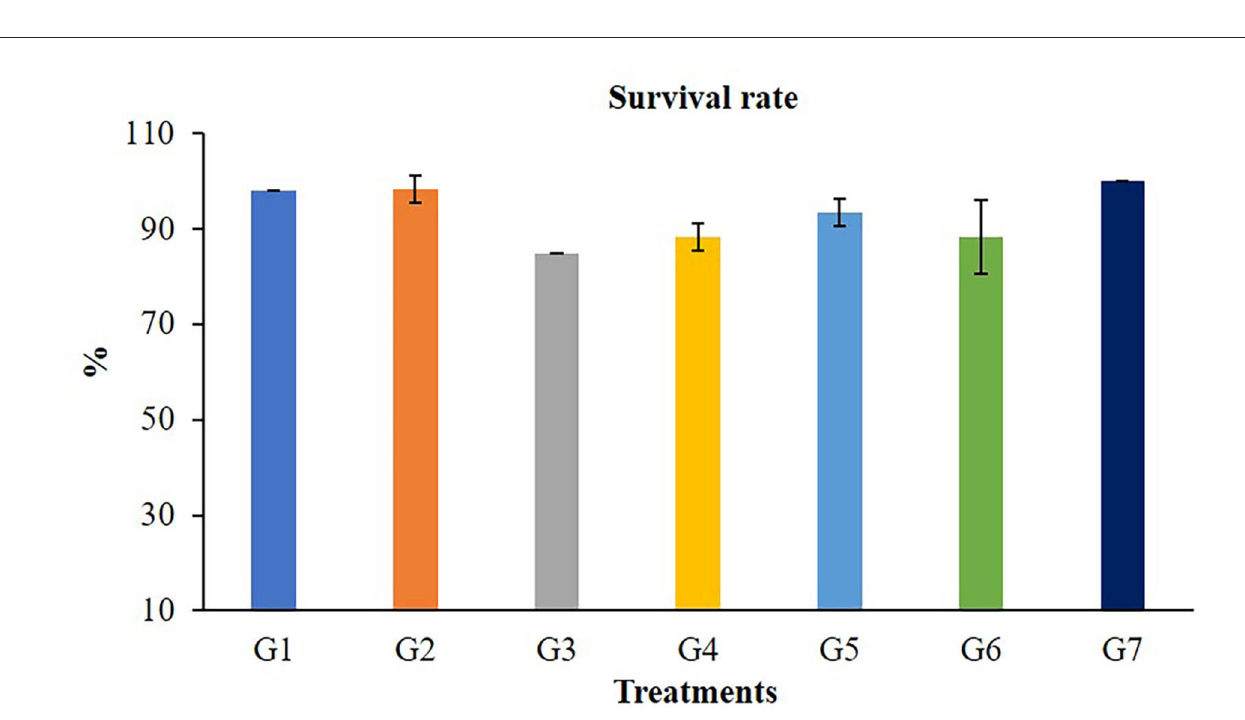
FIGURE2 Survival rate of Nile tilapia after fed a control feed and diets supplemented with different concentrations of FOS and B. subtilis for 56